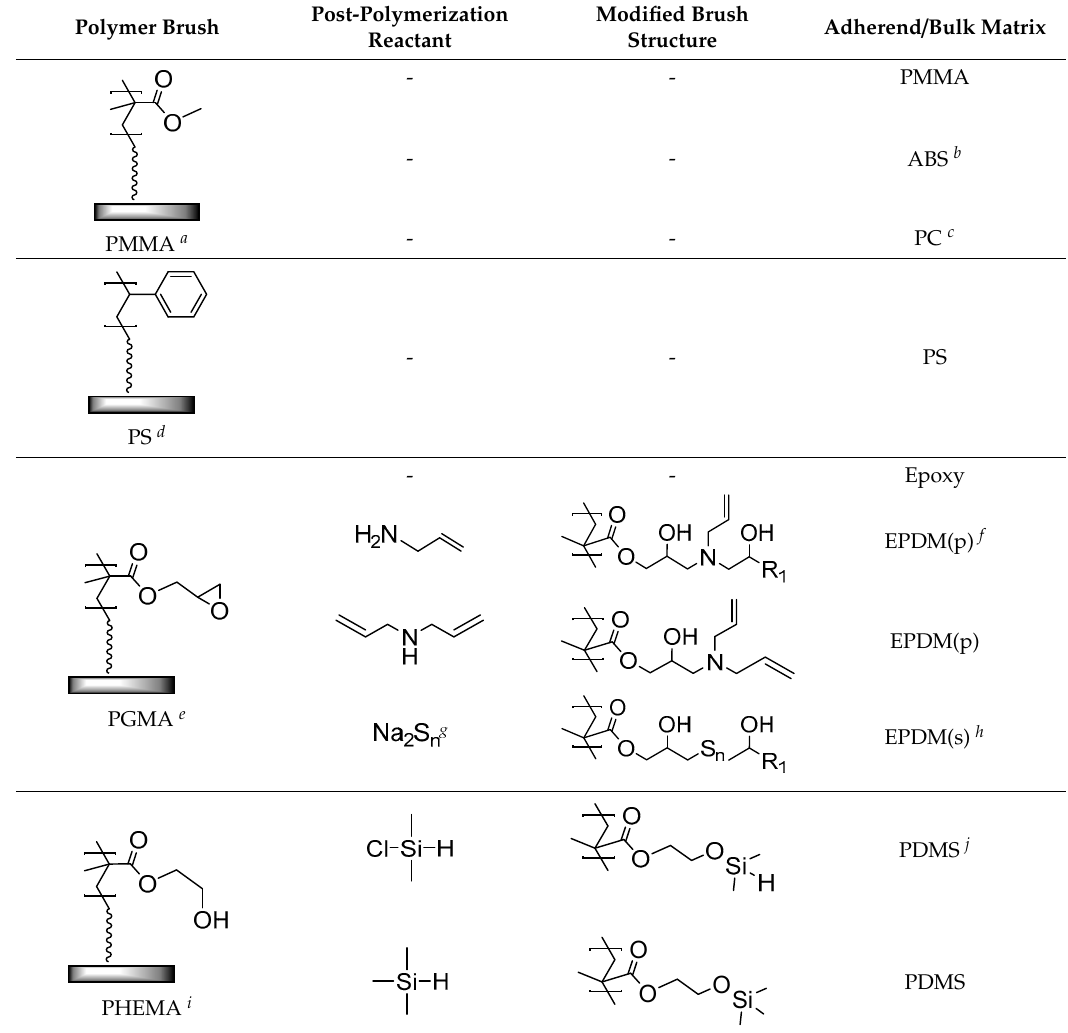
Table 1. Chemical structures of the polymer brushes, post-polymerization reactants, modified brush structure, and the adherends / matrixes discussed in this review.